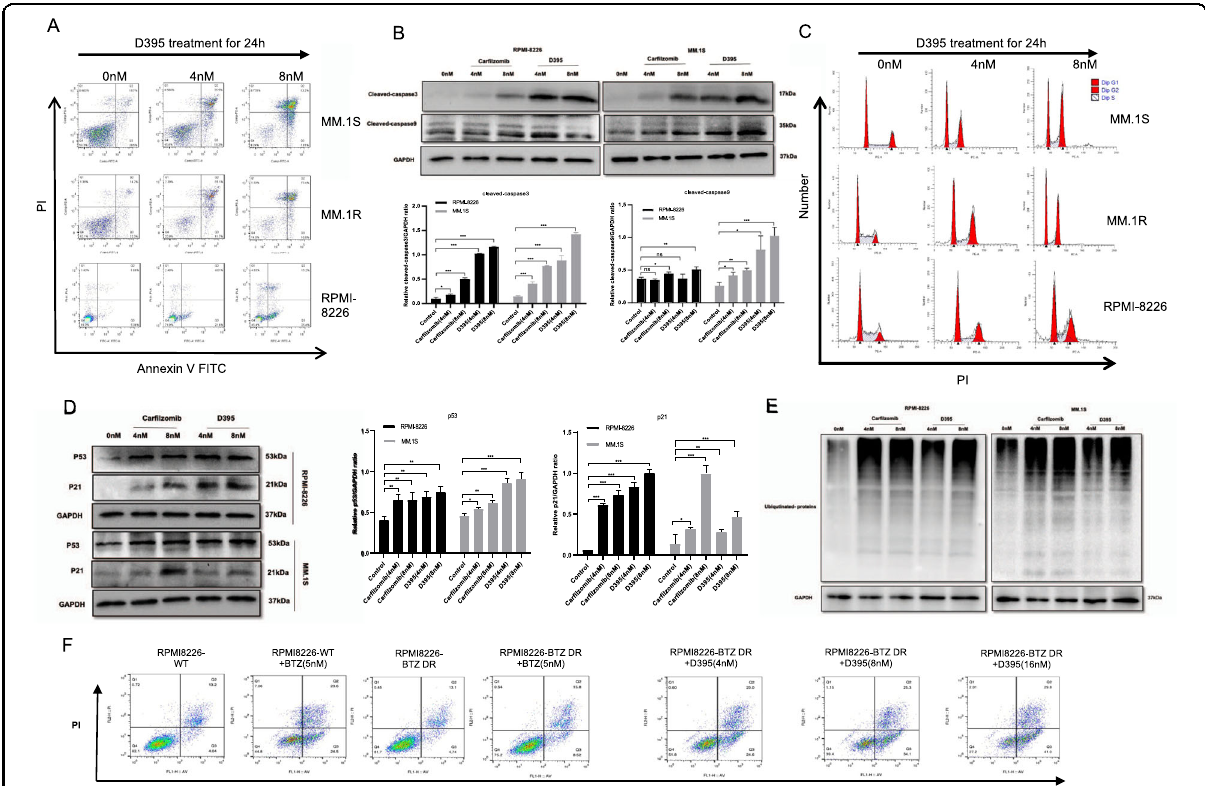
Fig. 3 D395 induces MM cell apoptosis and inhibits the cell cycle. A The apoptotic population of MM cells following exposure to D395 were detected by cell surface annexin V staining followed by fl ow cytometry. B Apoptosis pathway-related markers, including cleaved caspase 3 and cleaved caspase 9, were detected in cell lysates from RPMI-8226 and MM.1S cells by western blot after drug treatment for 24 h. C The cell cycle distribution in RPMI-8226, MM.1S and MM.1R cells treated with D395 for 24 h was determined by fl ow cytometry analysis. RPMI-8226 and MM.1S cells were pretreated with D395 or car fi lzomib for 24 h and then subsequently dissociated to determine the expression of the cell cycle ‑ associated proteins p53 and p21 ( D ) and polyubiquitinated proteins ( E ) by western blot. F RPMI-8226 WT and RPMI-8226 BTZ-DR cells were incubated with bortezomib (left) and different doses of D395 (right) then labeled with annexin V for fl ow